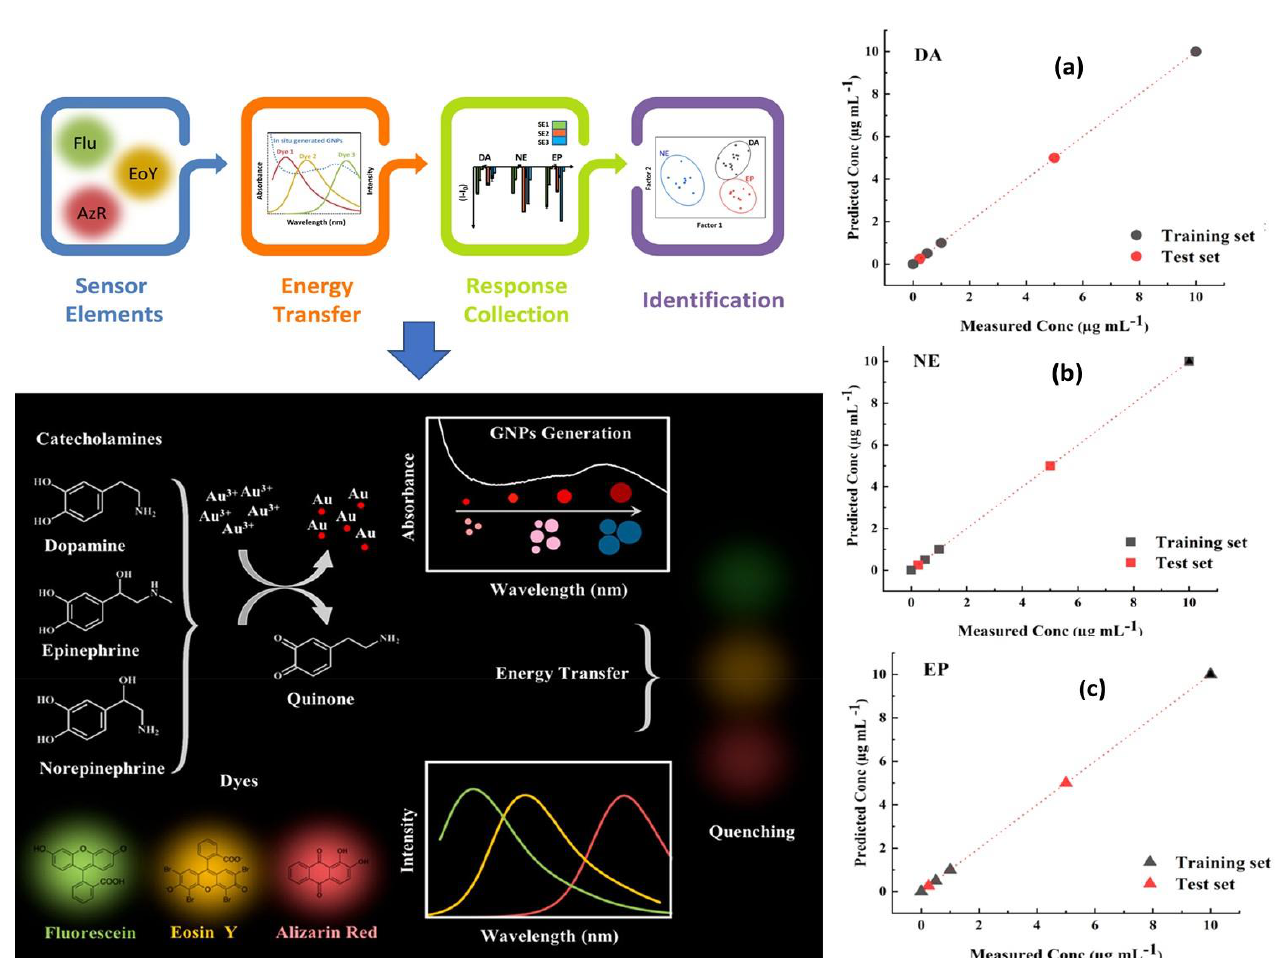
Figure 8. Schematic representation of the working principle and functionalization steps of fluorescence biosensor based AuNPs for simultaneous detection of catecholamine (DA, EP, and NE), and their associated predicted response versus measured concentration of ( a ) Dopamine, ( b ) Norepinephrine, and ( c ) Epinephrine. Reproduced with permission from [188]. Copyright 2020, ACS.